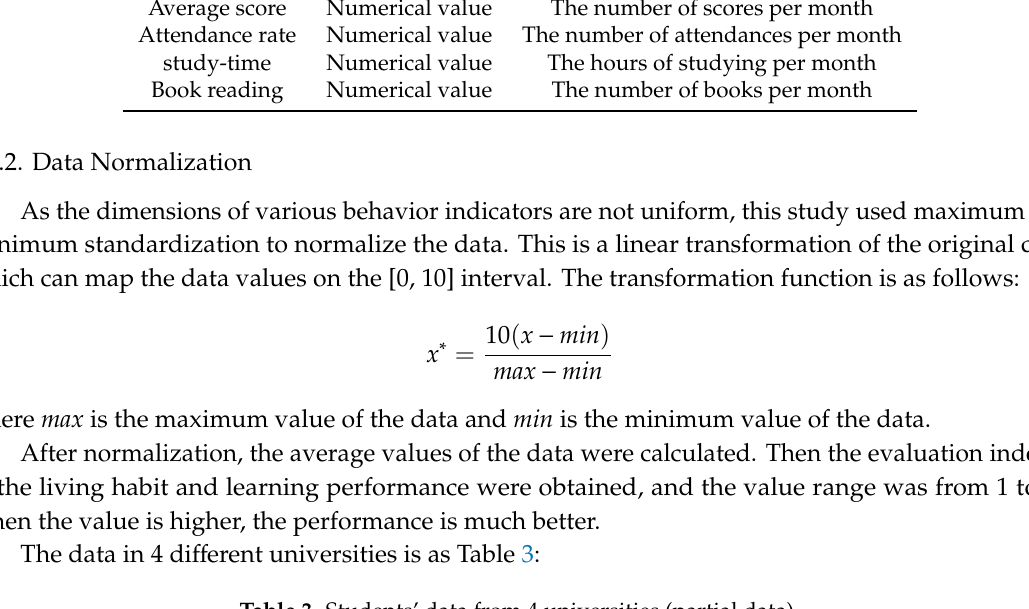
Table 3. Students’ data from 4 universities (partial